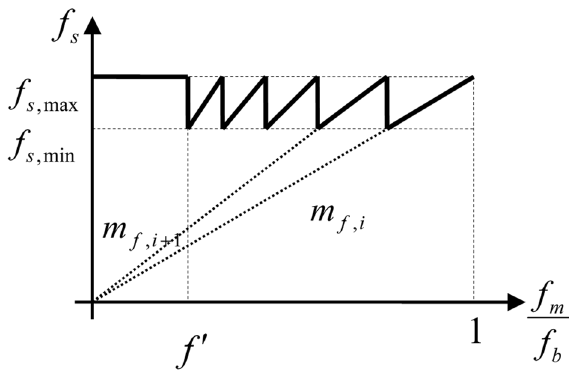
Figure 2. Carrier frequency and modulating frequency relation.